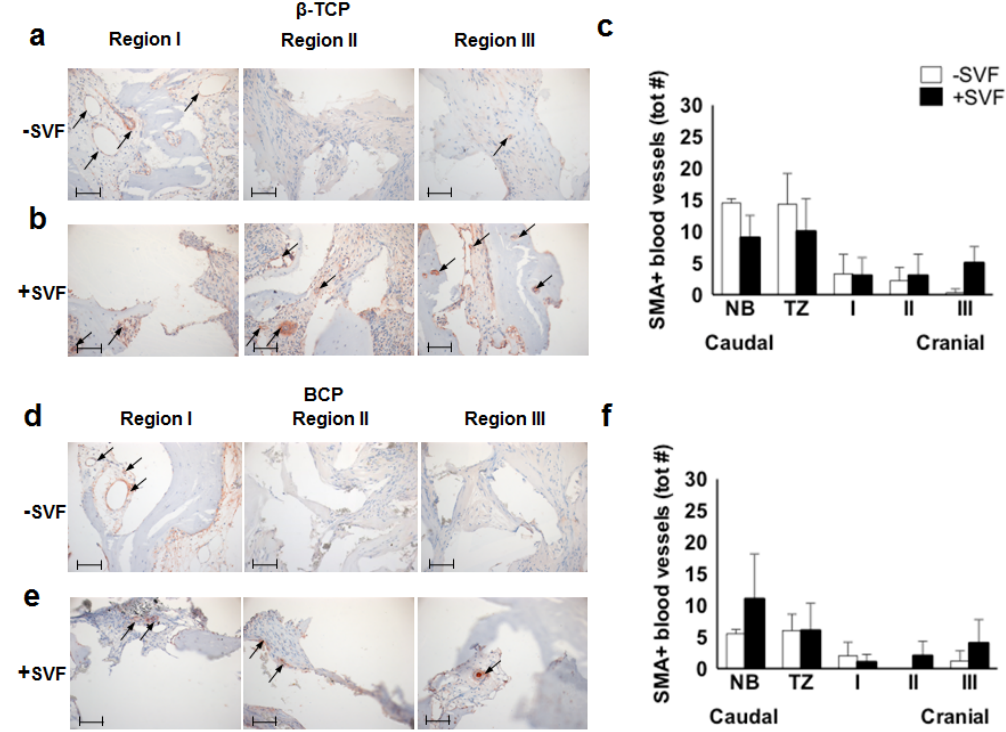
Figure 4. Immunohistochemical analysis of α -smooth muscle actin (SMA), a marker of pericytes, as well as smooth muscle cells present in the blood vessel walls, of a maxillary bone biopsy from a patient treated with β -TCP ( a – c ) and BCP ( d – f ). Magnification: 200 × . The scale bar represents 100 µ m. The total number of SMA+ blood vessels of selected bone biopsies taken from control sides without stem cells (white bars; n = 3), and study sides with stem cells (black bars; n = 5) from patients treated with β -TCP ( b ) or BCP ( e ). β -TCP, β -tricalcium phosphate; BCP, biphasic calcium phosphate; NB, native bone; TZ, transition zone; SVF, stromal vascular fraction; tot #, total number.